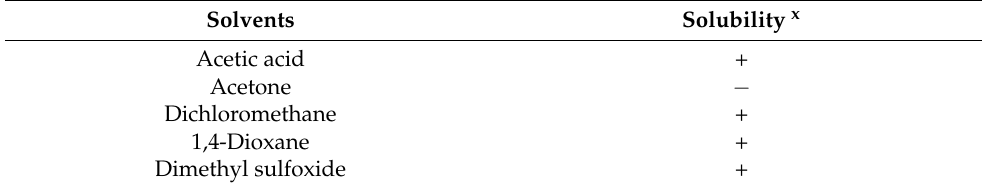
Table 3. The solubility of CTA in common solvents. Solvents Solubility x Acetic